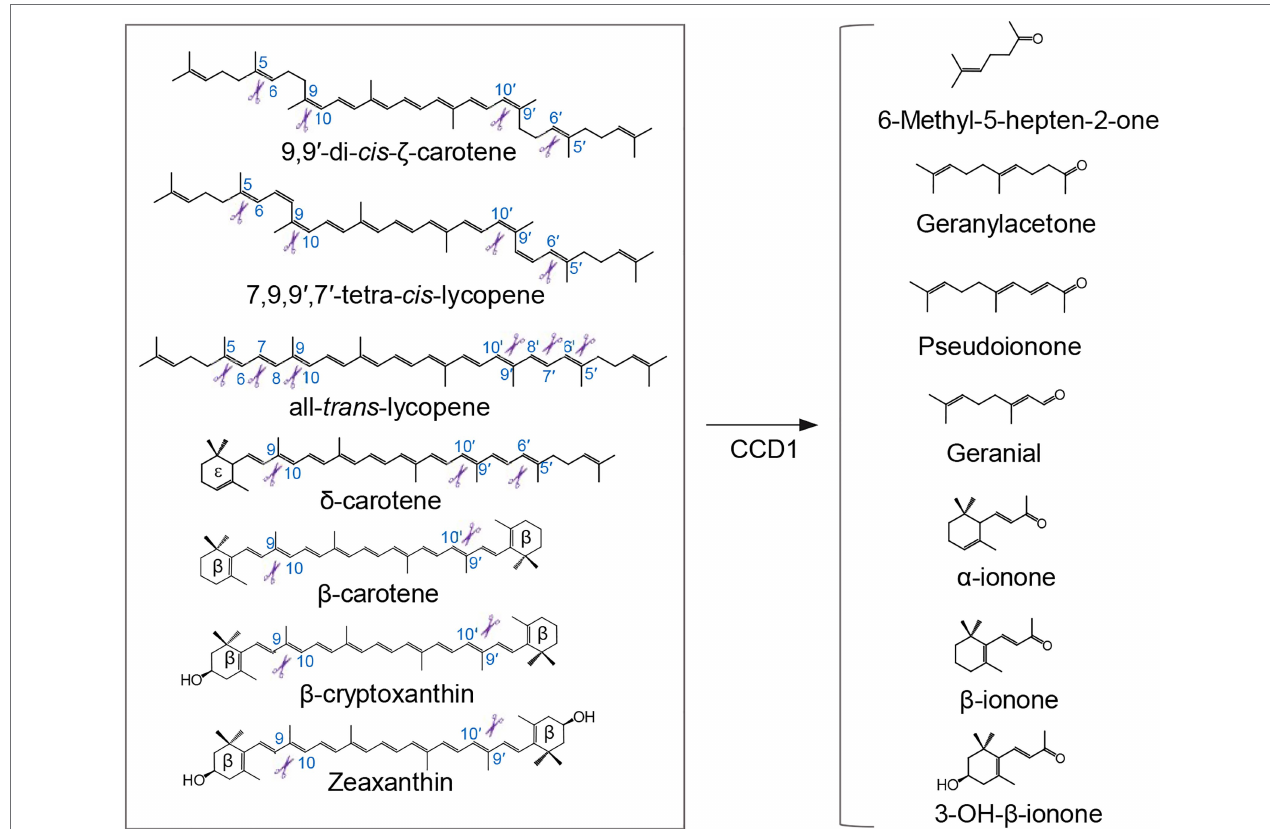
FIGURE 2 | Cleavage of carotenoid substrates by CCD1 enzyme and examples of generated volatiles. Plant CCD1 enzymes can cleave linear, monocyclic, and bicyclic carotenoid and apocarotenoid substrates at different double bonds in E. coli and/or in vitro , yielding various apocarotenoid volatiles, in addition to a plentitude of apocarotenoid dialdehydes (not shown). Scissors indicate the double bond positions cleaved by